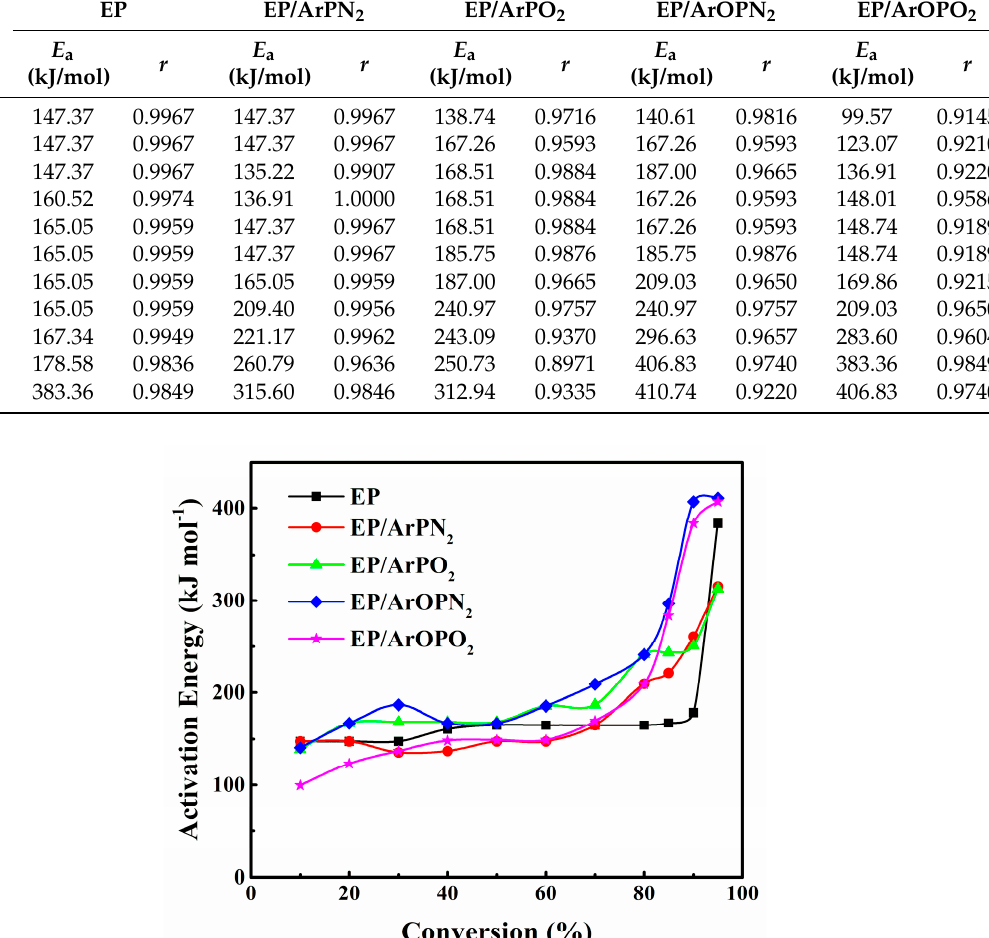
Figure 7. Activation energy curves of pure EP and EP/polysulfone composites.